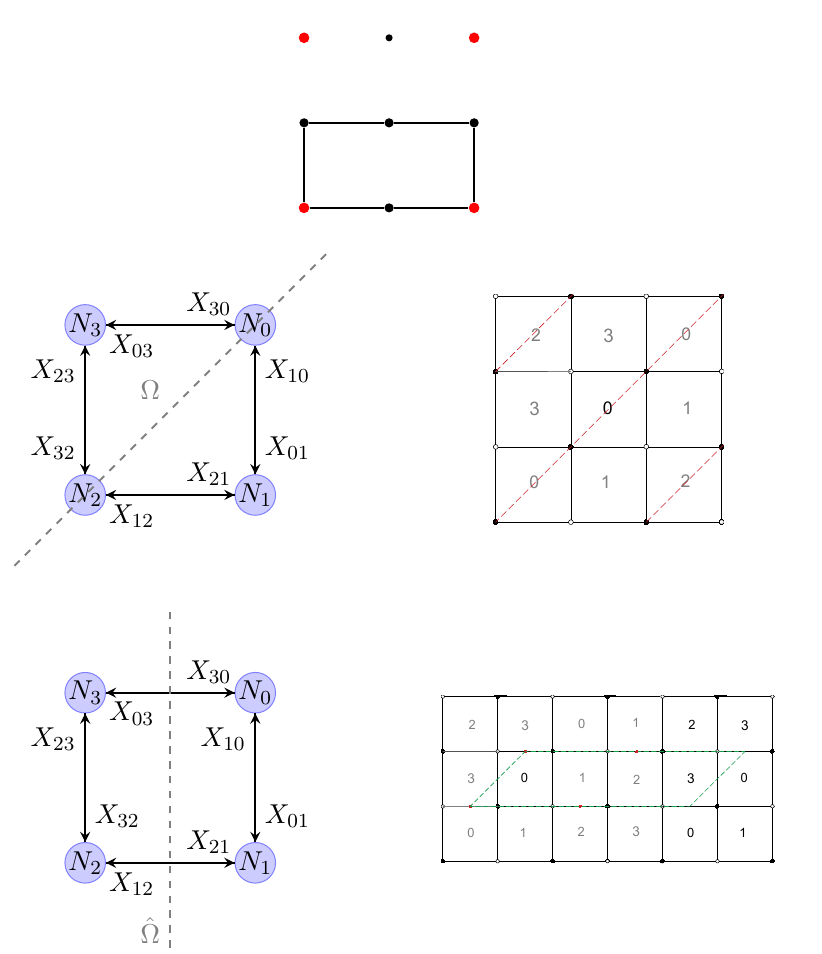
Figure 32. The various unoriented descriptions of the non-chiral C = Z 2 . The upper (cid:12)gure shows a possible toric diagram from which one can notice the presence of a non-compact (cid:10)7 and a (cid:10)3 or only a non-compact (cid:10)7, depending on how the toric diagram is triangulated. The middle row shows the orientifold involution (cid:10), on quiver (left) and dimer (right), while in the lower row are drawn the quiver (left) and the dimer (right) for the involution ^(cid:10).